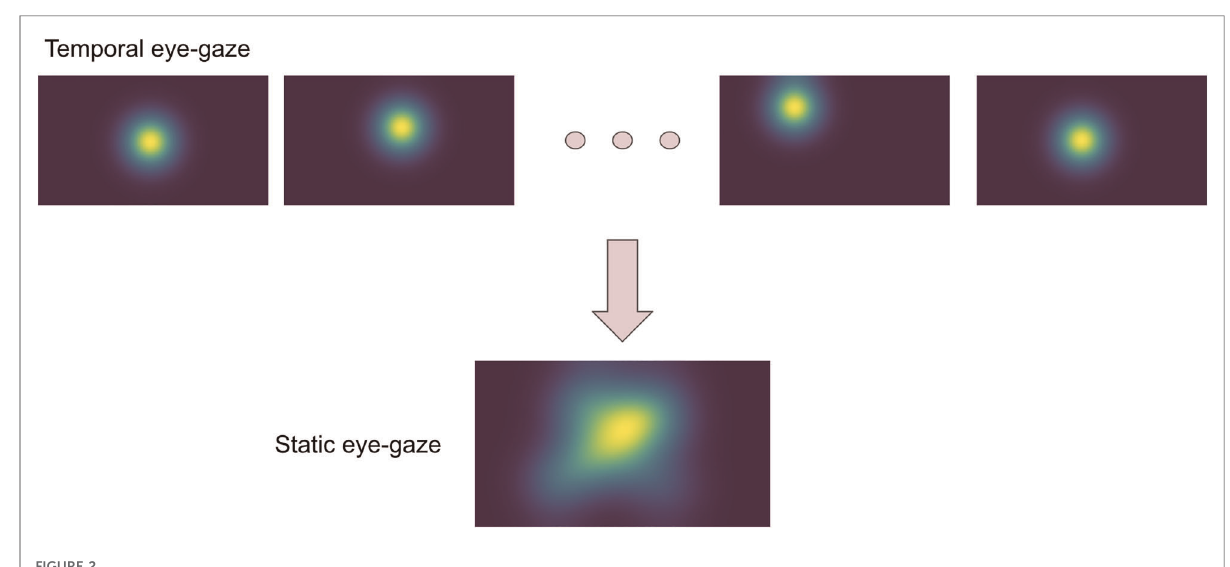
FIGURE 2 Temporal and static eye-gaze